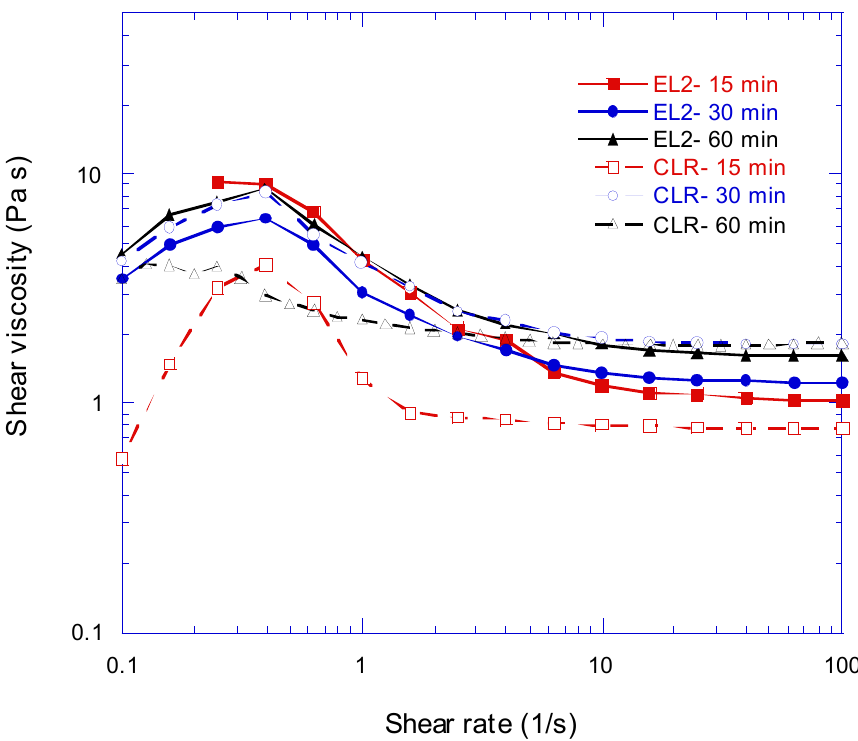
Figure 1. Viscosity versus shear rate for EL2 epoxy and CLR bio-based epoxy at three different time points after mixing with the hardener.